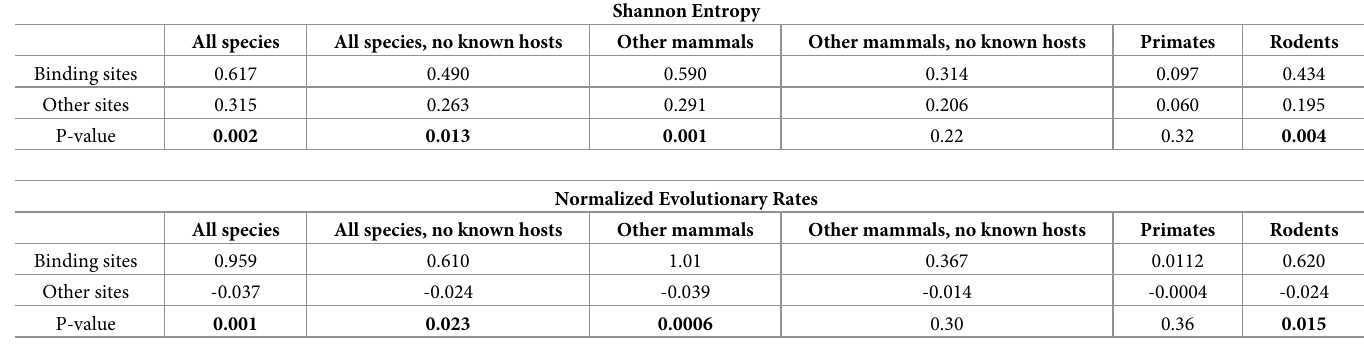
Table 1. Mean evolutionary rates as determined by Shannon entropy (top) and Rate4Site (bottom) of ACE2 sites within each species group for spike-binding sites and all other surface-exposed extracellular sites. Shannon Entropy